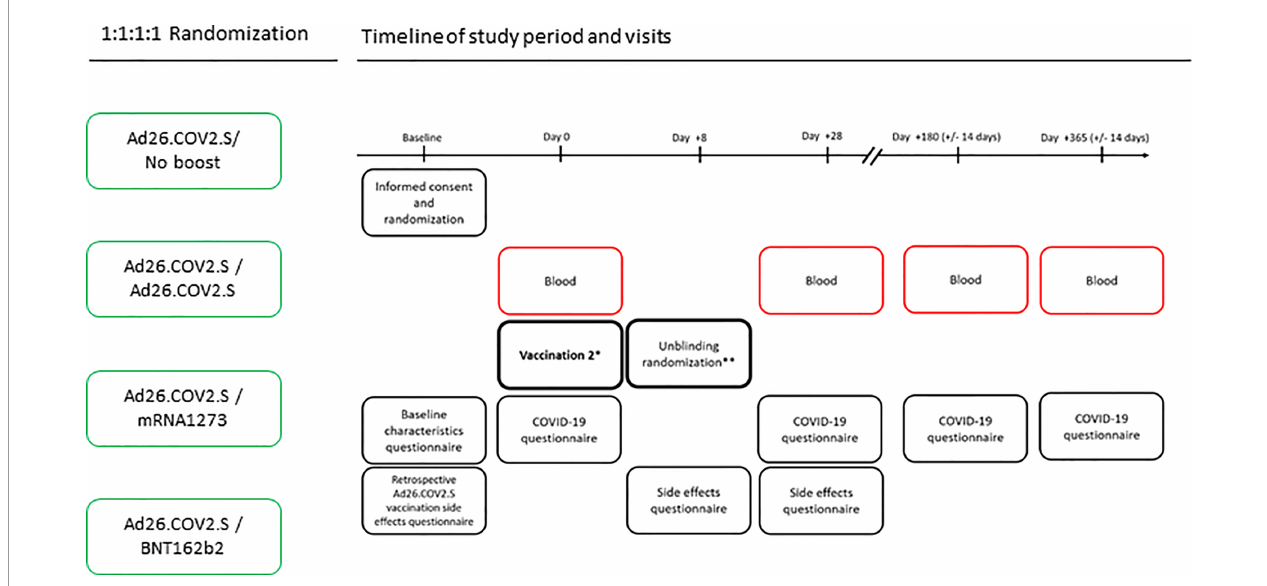
FIGURE 1 | SWITCH trial design. The SWITCH trial includes four arms that receive a booster vaccination 84 days after prime with Ad26.COV2.S. Blood samples will be collected at indicated timepoints by venepunctures. Questionnaires will be performed to collect reactogenicity data and to determine whether participants had breakthrough infections despite vaccinations. *One of the four arms or 25% of the randomized participants will not receive a second vaccination; **Unblinding the randomization of participants will be done after the side effects (i.e., reactogenicity) questionnaire is